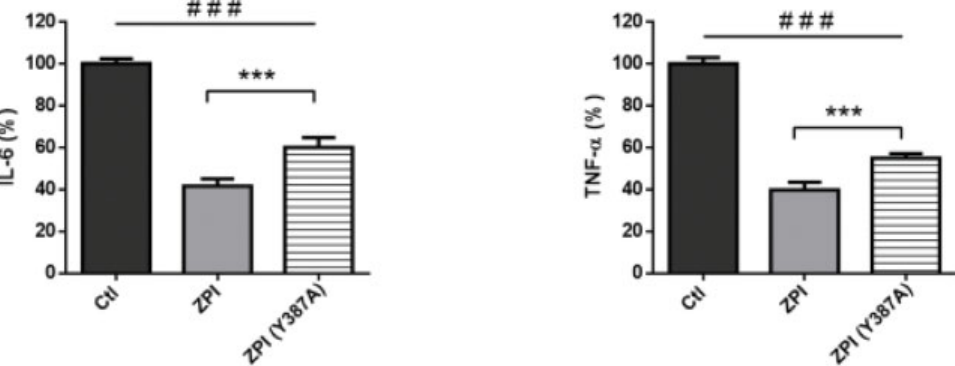
Fig. 4 Effects of the rhZPI-Y387A variant on the secretion of IL-6 and TNF- α in whole blood activated by lipopolysaccharide (LPS). Comparison with wild-type rhZPI (ZPI) effects. Cytokines were quanti fi ed after a 20 hours incubation. rhZPI-Y387A or rhZPI were added at 250 nM 30